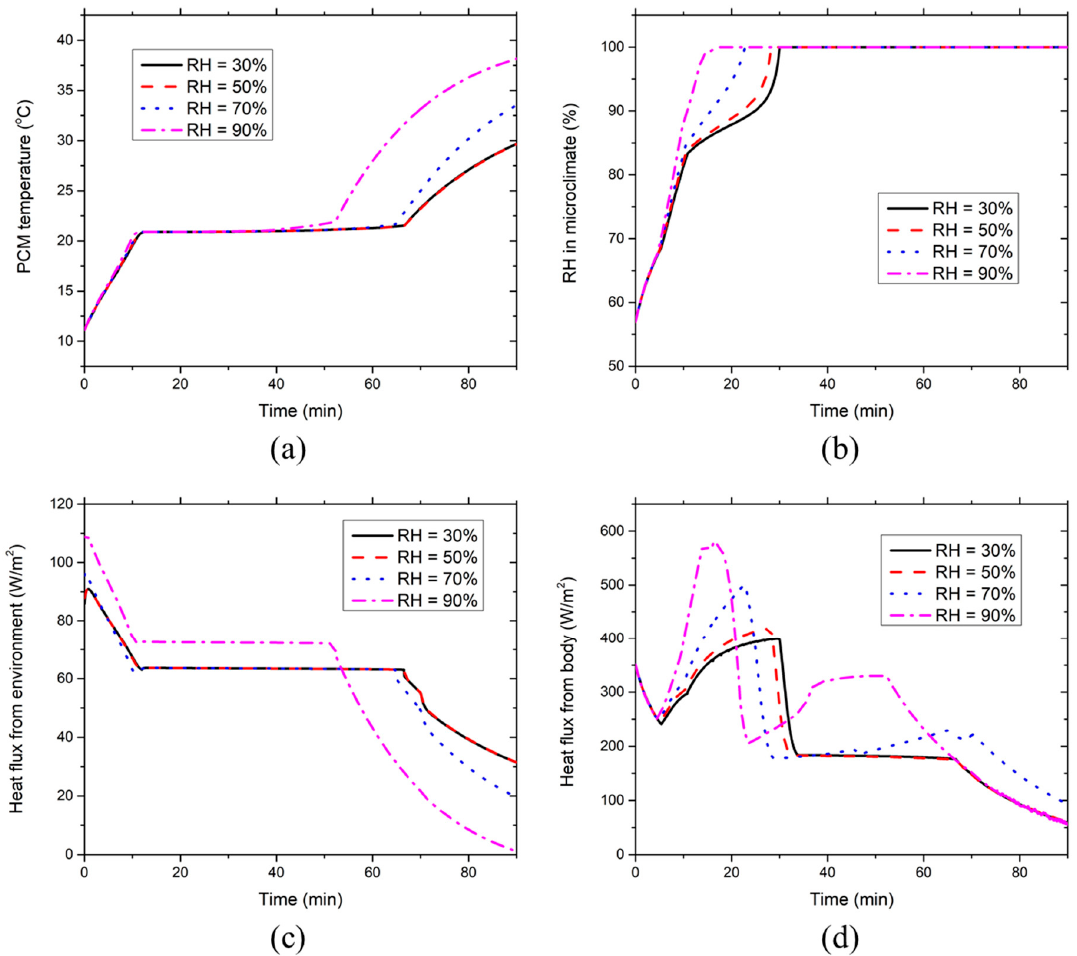
Figure 10. Effect of environmental RH on the time course of ( a ) PCM temperature, ( b ) clothing microclimate RH, ( c ) PCM heat absorption from the environment and ( d ) PCM heat absorption from the body at the chest segment covered with PCMs and insulation pads at the ambient temperature of 40 °C.